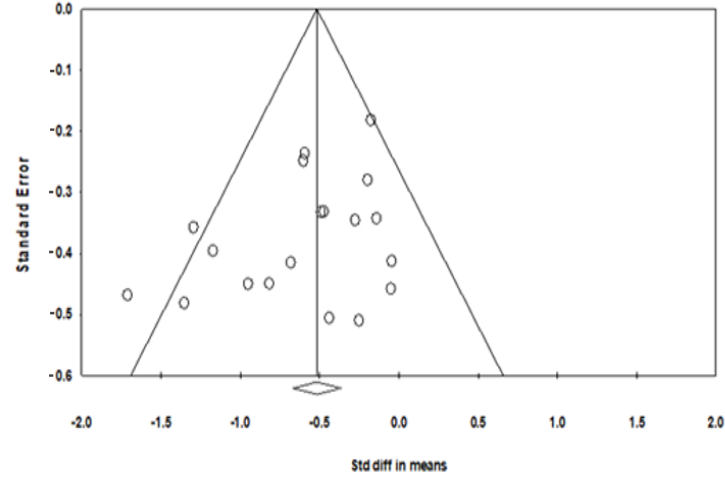
Figure 2. Funnel plot of publication bias for depression.